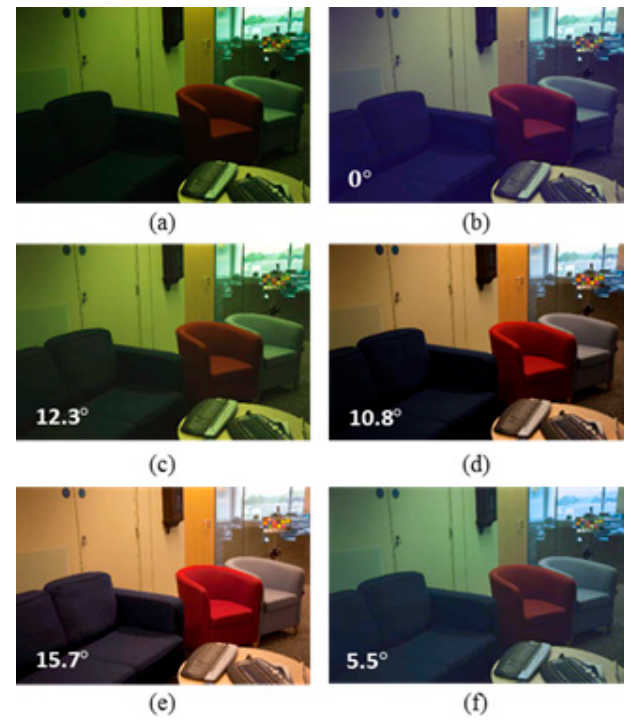
Figure 2. Original, ground truth and its colour-balanced images using different colour correction methods: ( a ) Original image from the Colour Checker dataset [48], ( b ) Ground truth image, ( c ) Weighted Grey Edge, ( d ) Corrected Moment, ( e ) Cheng et al. and ( f ) Proposed CCAFIS’ methods’ images.